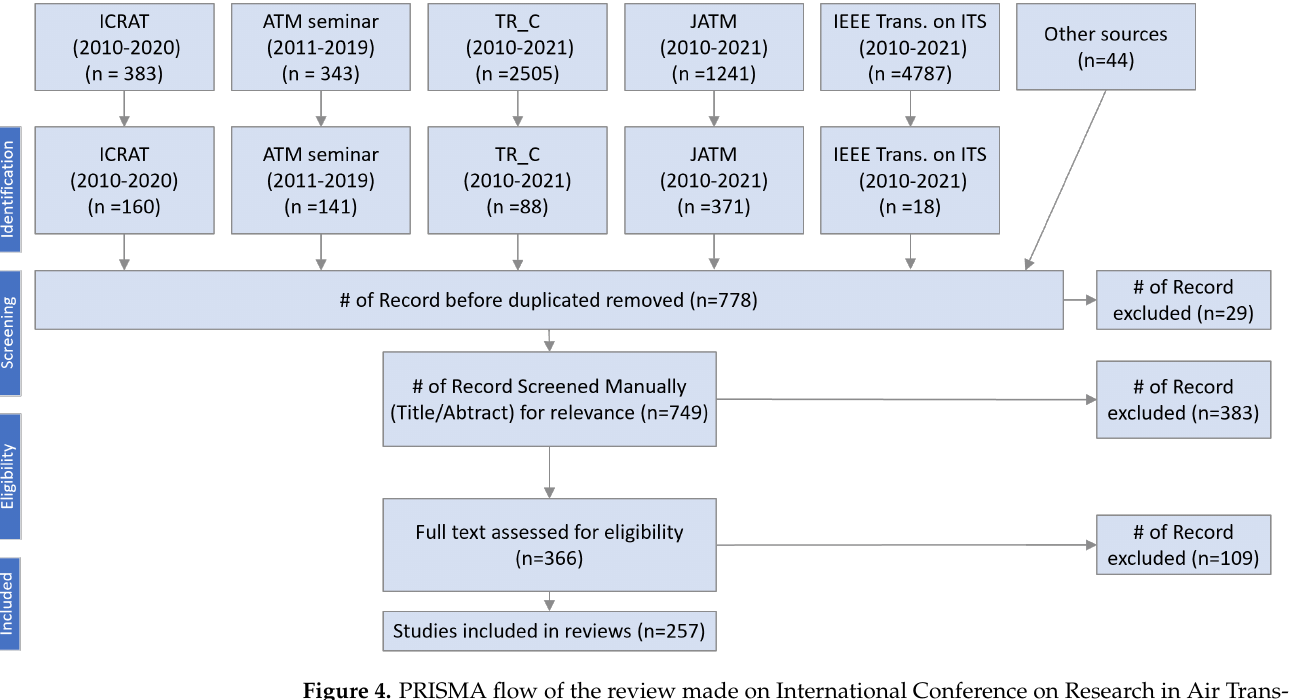
Figure 4. PRISMA flow of the review made on International Conference on Research in Air Trans-